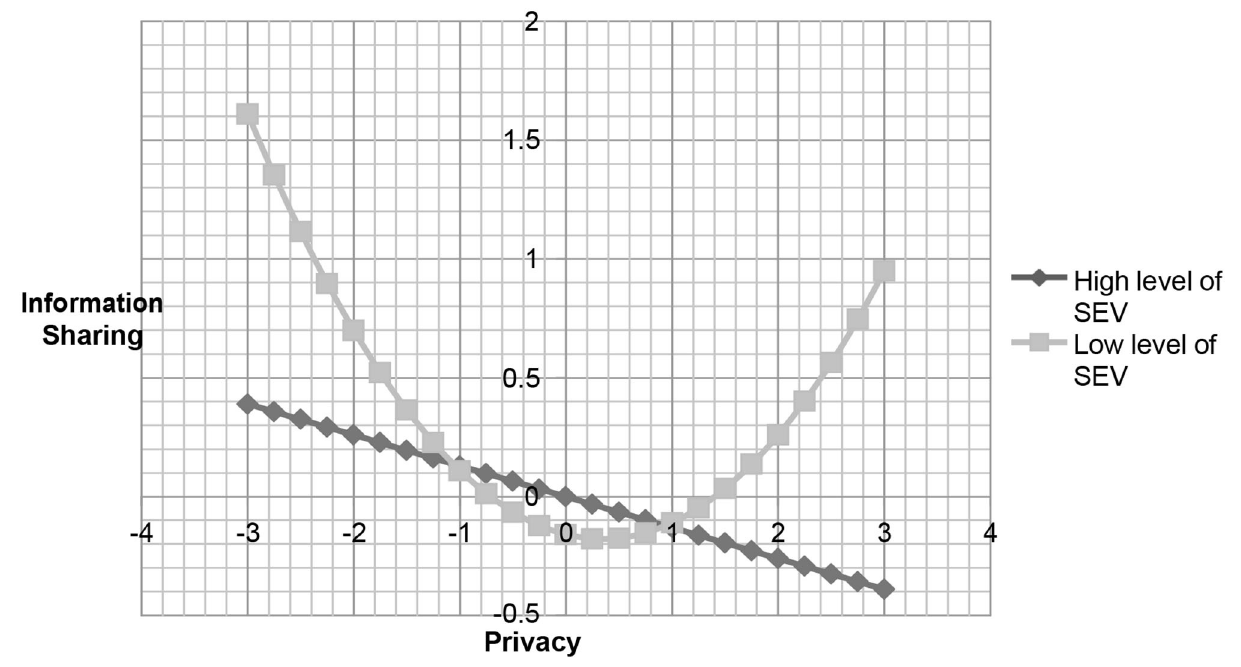
between PC and information sharing. In addition, Model 5 also demonstrates that the regression coefficient of the interaction term is significantly positive between PC² and motivation ( ß = 0.14, p < 0.01), supporting our hypothesis 3 that